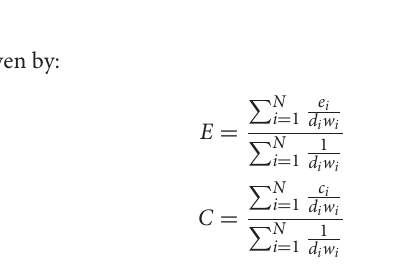
FIGURE 2 | Schematic representation of the